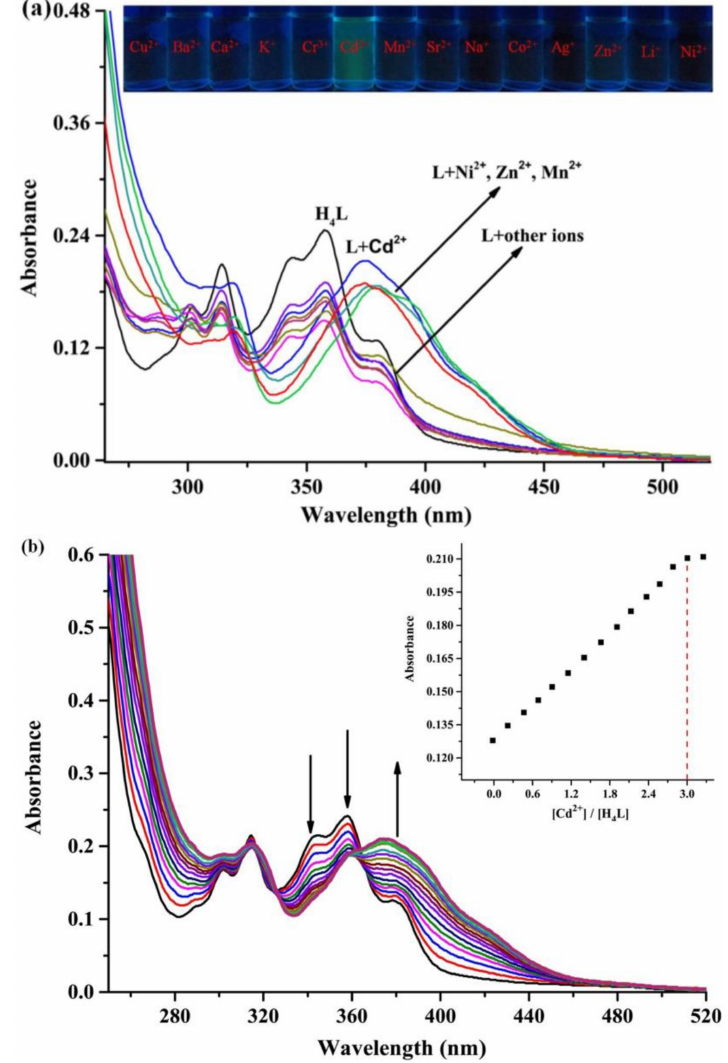
Figure 3. ( a ) UV-vis spectra of sensor H 4 L (1 × 10 − 5 M) recorded in Tris-phosphate buffer (c = 0.2 M, DMF/H 2 O = 9:1, v / v , pH = 7.0) solutions after addition of 3.0 equiv. of metallic ions (1 × 10 − 3 M); ( b ) Absorption spectra of sensor H 4 L in Tris-phosphate buffer (c = 0.2 M, DMF/H 2 O = 9:1, v / v , pH = 7.0) solutions upon gradual addition of Cd 2+ (0.0 to 3.0